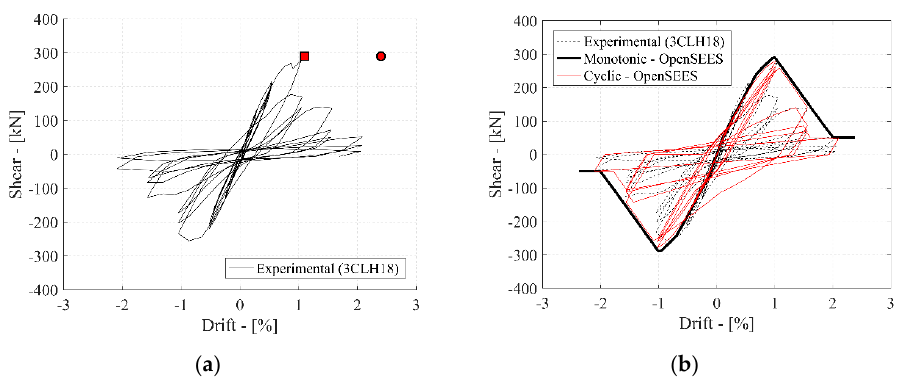
Figure 13. Specimen 3CLH18: ( a ) Experimental behaviour. The square and circle marks represent respectively the experimental (Table 2) and calculated (Equation (17)) initiation of shear degradation. ( b ) Comparison of numerical cyclic response with experimental results. Table 2. Experimental values needed for the calibration of the shear spring (Figure 4).